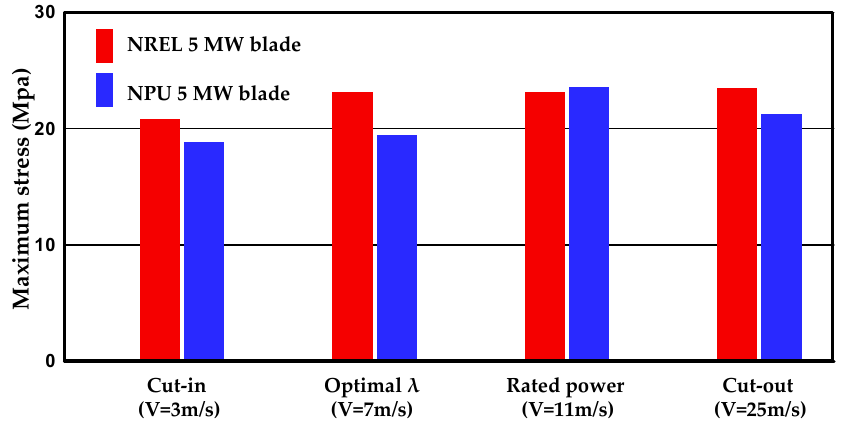
Figure 32. The maximum stress of blade tip at different working conditions.